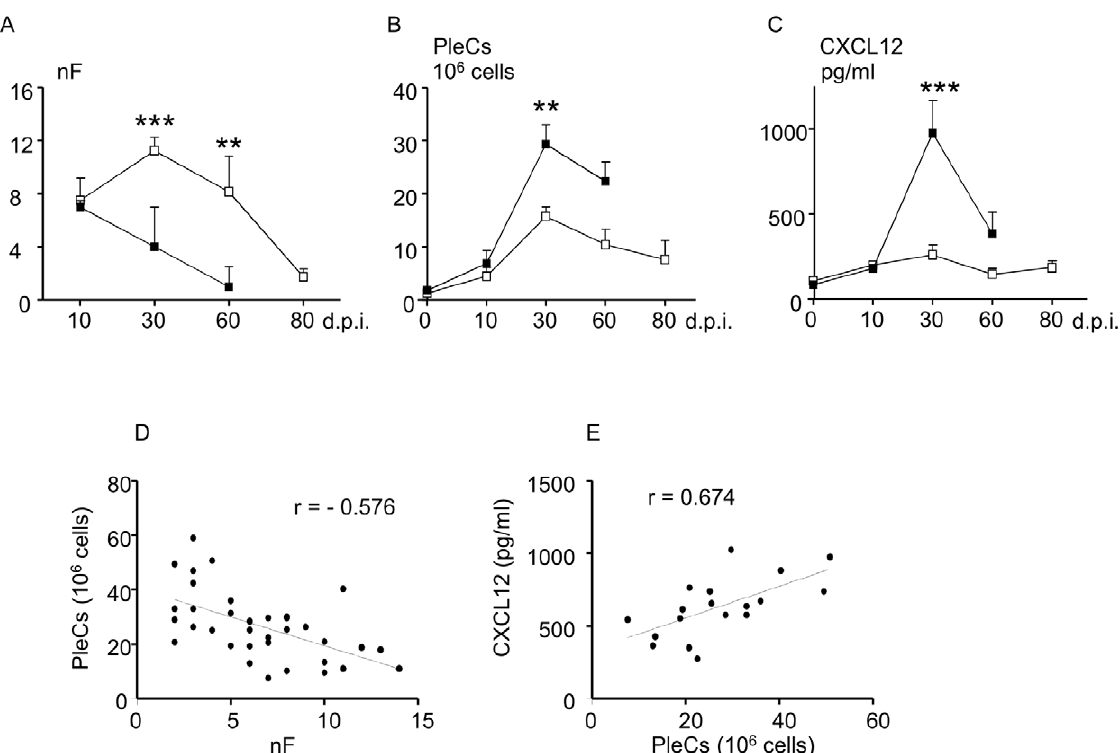
Figure 1. Filarial survival, pleural cell recruitment and CXCL12 levels during the course of the infection. A. Worms were collected during the infection time course from 10 days p.i. to 60 daysp.i in C57BL/6 mice and 80 days p.i. in BALB/c mice and were counted (nF). B. Pleural exudate cells (PleCs) were isolated at necropsy by flushing the pleural cavity and counted. C. The level of CXCL12 was measured during the course of infection in pleural washes of C57BL/6 and BALB/c mice by ELISA (eBiosciences). Open squares represent BALB/c mice, black squares C57BL/6 mice. Results are expressed as mean 6 SEM of 3 independent experiments pooled together, each carried out with 6 mice per group. The differences between strains and the modifications during time course of the infection were analyzed by a two-way analysis of variance. For each analysis (nF, PleCs, CXCL12), strain and time effects were significant. Comparison between strains for each time point was further assessed by Bonferroni’s multiple comparison test. The character ‘‘*’’ represents significant differences between the C57BL/6 mice and the BALB/c mice (**p , 0.005, ***p , 0.001). D. Correlation between the filarial load and number of the pleural exudate cells was assessed by Spearman’s test (r= 2 0.576, p , 0.01). E. Correlation between the number of pleural exudate cells and the pleural CXCL12 concentration was assessed by Spearman test (r=0.674, p , 0.01). Graphs show the linear regression between the factors.